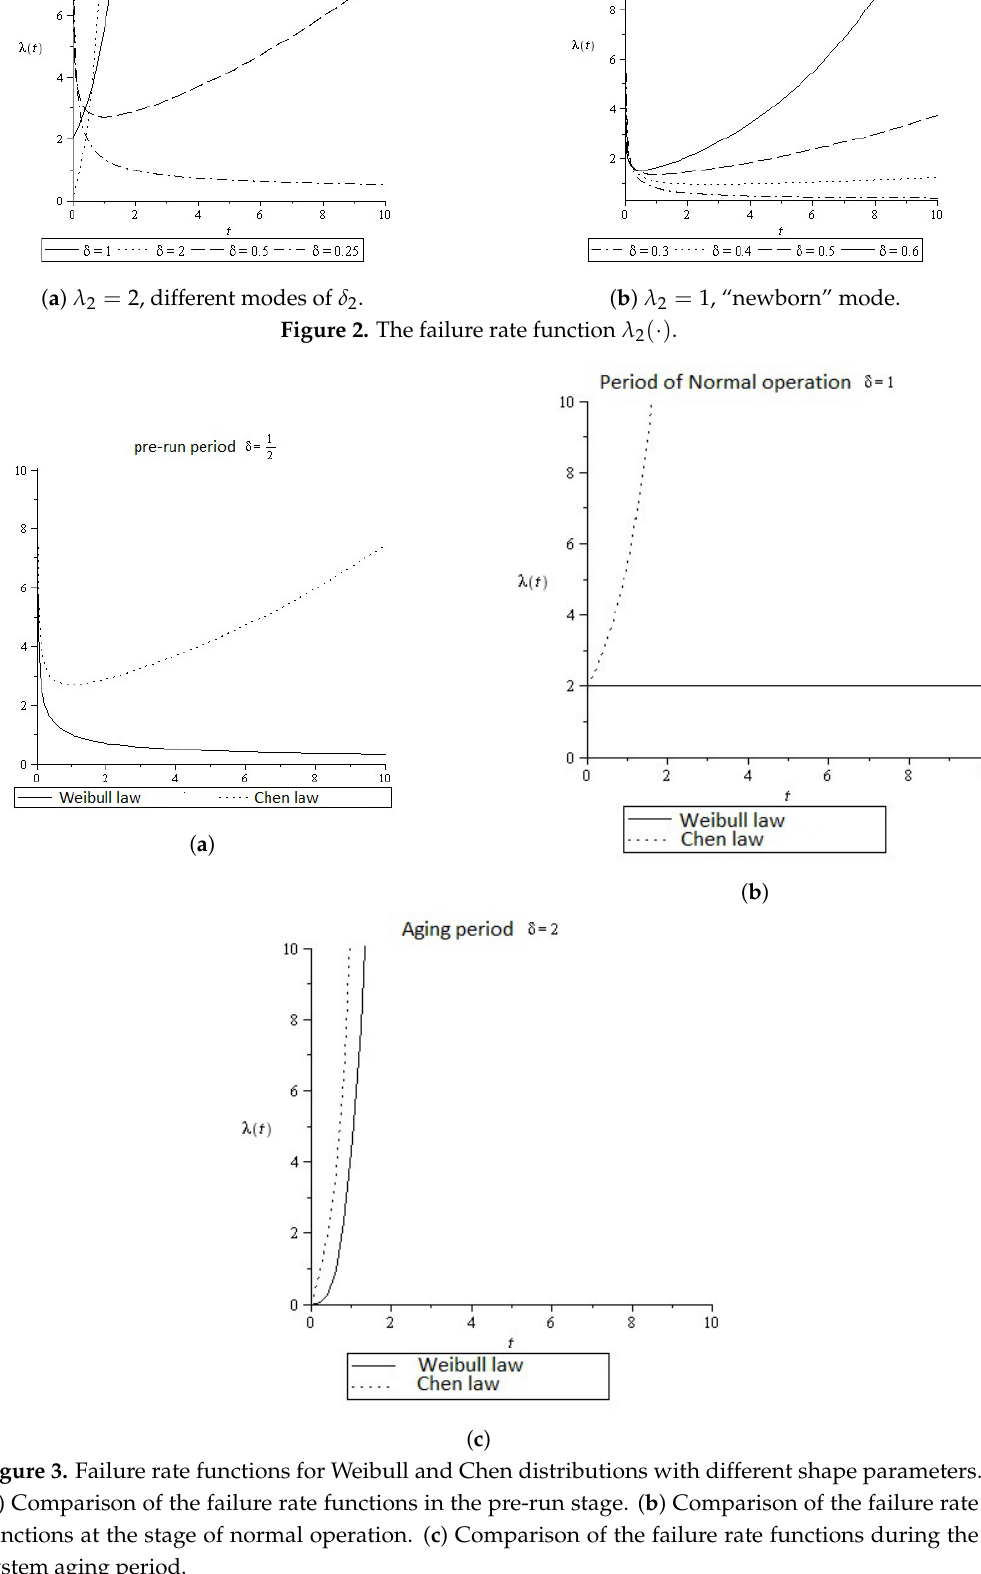
Figure 3. Failure rate functions for Weibull and Chen distributions with different shape parameters. ( a ) Comparison of the failure rate functions in the pre-run stage. ( b ) Comparison of the failure rate functions at the stage of normal operation. ( c ) Comparison of the failure rate functions during the system aging